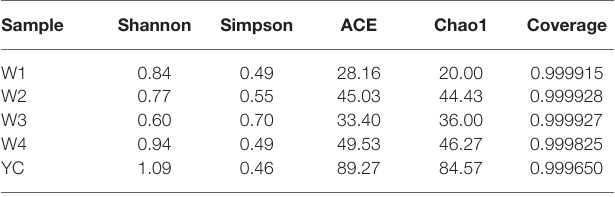
TABLE 2 | Indices of fungal community richness and diversity of Sichuan dark tea. Sample